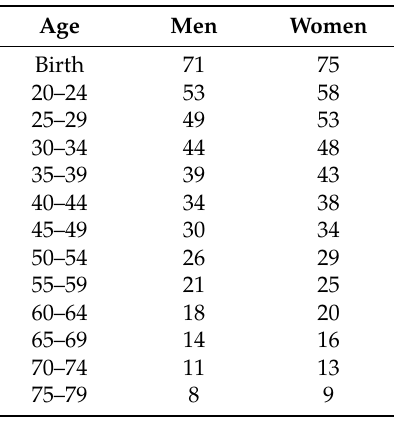
Table A1. Life expectancy in